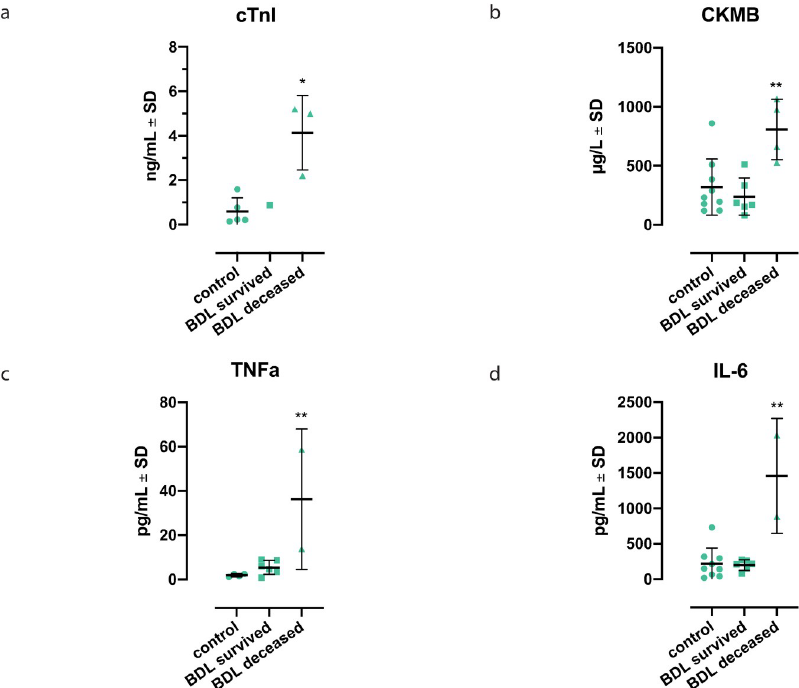
operated controls 31 days after BDL. Significantly higher (a) cTnI values ( � p = 0.011, control n = 5, BDL survived n = 1, BDL deceased n = 3), (b) CKMB values ( �� p = 0.008, control n = 9, BDL survived n = 6, BDL deceased n = 4), (c) TNF α values ( �� p = 0.003, control n = 4, BDL survived n = 6, BDL deceased n = 2) and (d) IL-6 ( �� p = 0.006, control n = 9, BDL survived n = 6, BDL deceased n = 2) were observed in rats that died early after BDL compared to respective controls. Displayed are the mean values ± SDs, and p < 0.05 was considered